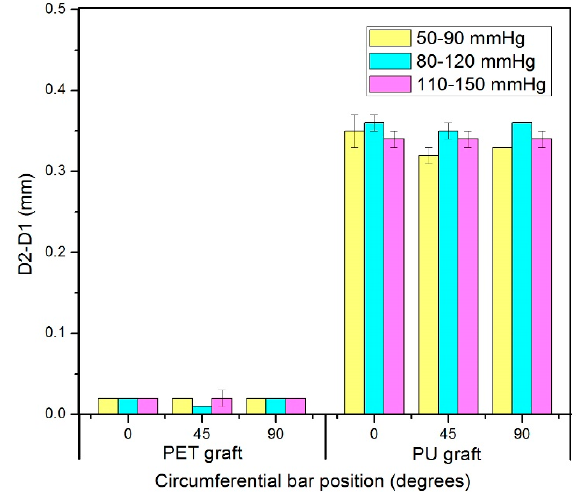
Figure 9. Diameter changes of PET and PU grafts in three circumferential bar positions.